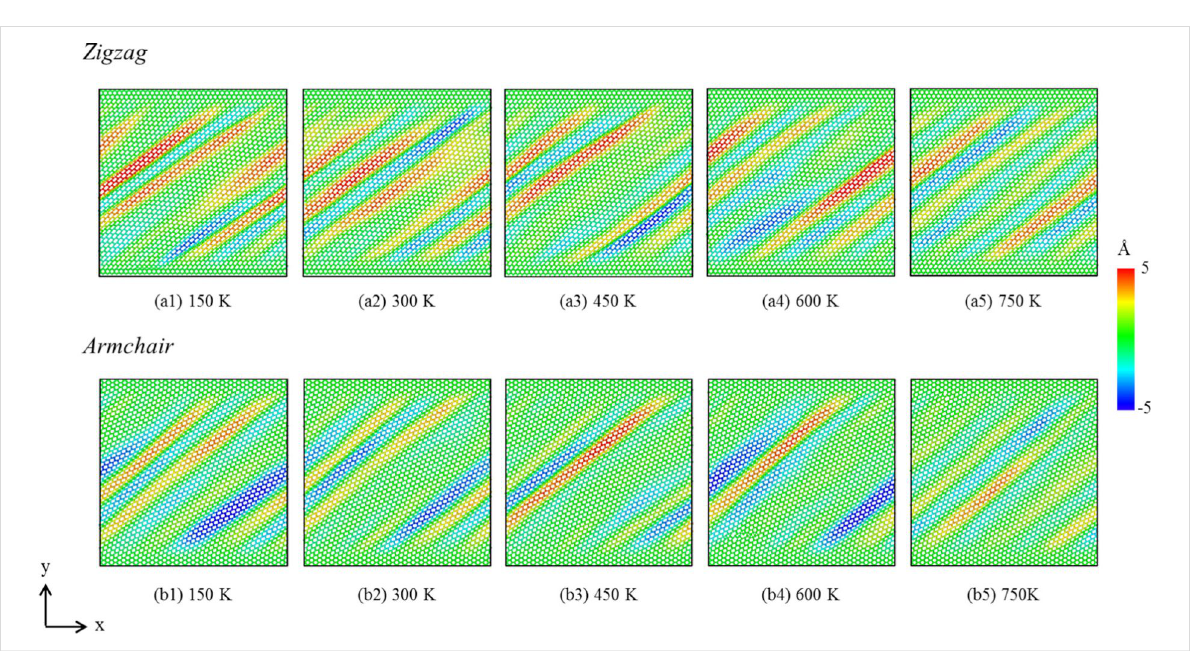
Figure 9: Out-of-plane displacement of graphene at different temperatures. (a1–a5) Zigzag graphene, (b1–b5) armchair graphene.